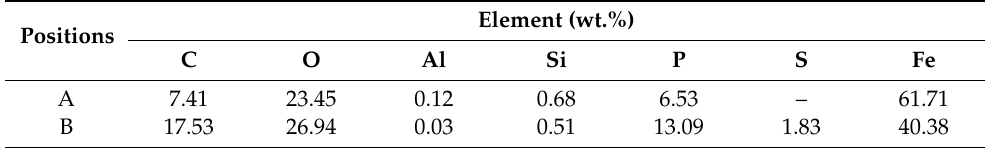
Figure 3. SEM images of the corrosion products on the specimen surface in sterile solution ( a , b ) and SRB-containing solution ( c , d ) after 14 days of immersion. Table 3. Results of EDS of the corrosion products on the steel